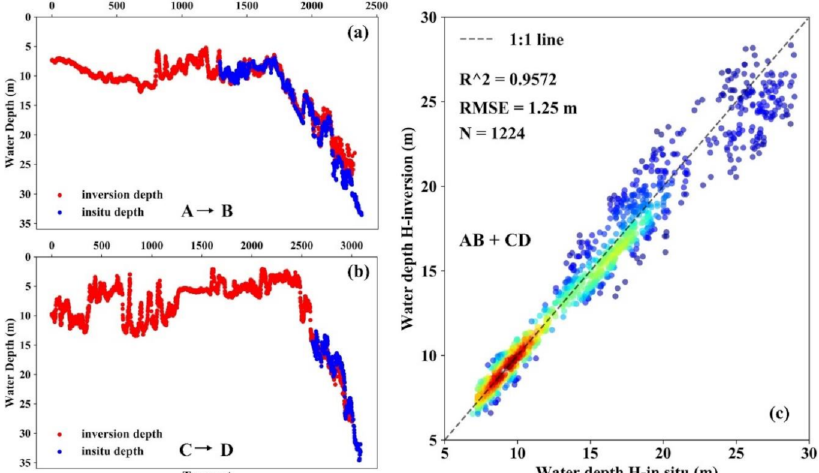
Figure 11. ( a , b ) Validation of the inversion depth with in-situ depth along AB and CD on WorldView- 2. ( c ) Fitting result between the in-situ and inversion water depth of the points selected on AB and CD of WorldView-2.